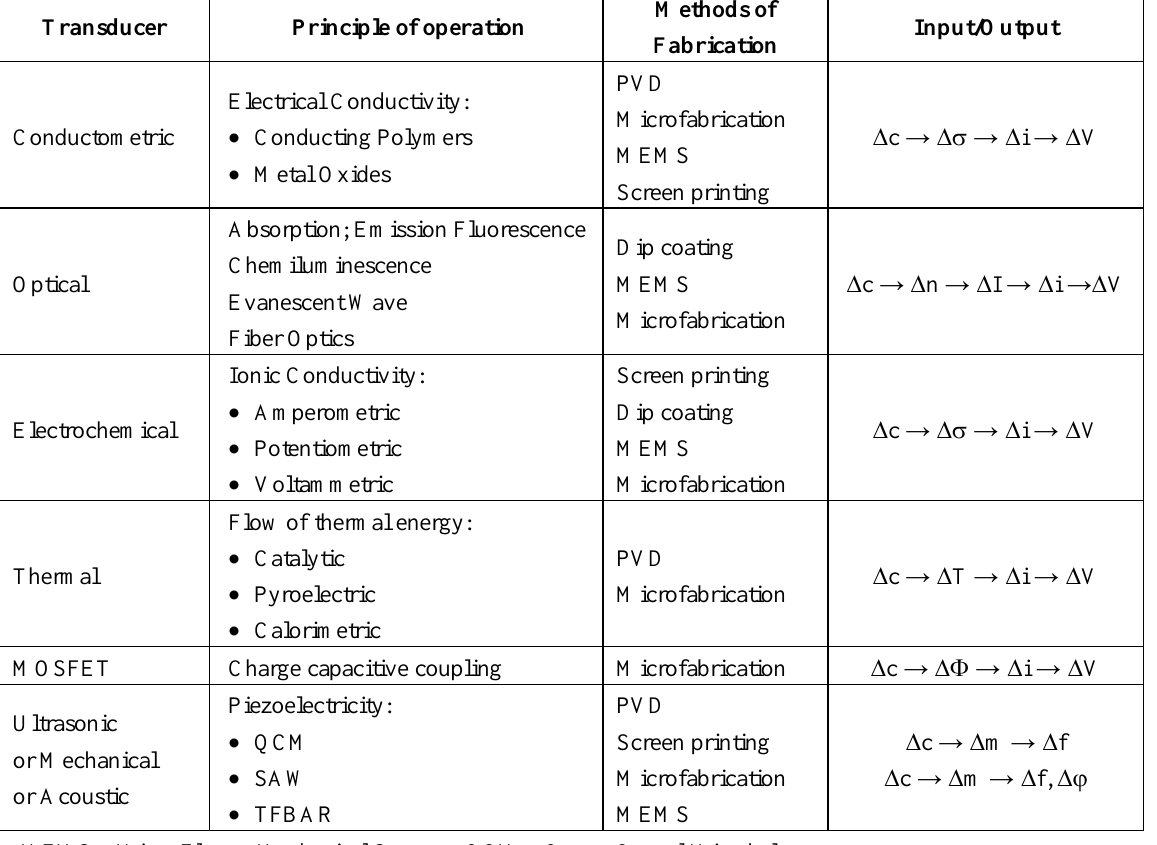
Table 2. Transducers used in chemical solid-state